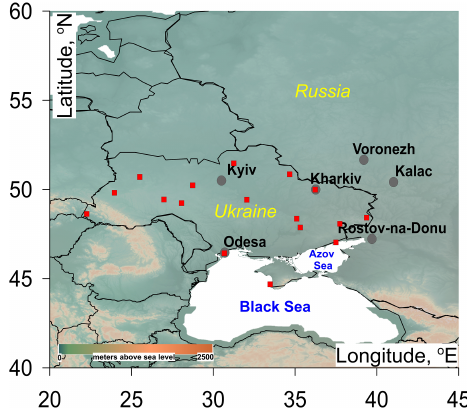
Figure 1. The area of interest and geographical locations of the radiosounding stations (black circles – Kyiv, Odesa, Kharkiv, Voronezh, Rostov-on-Don, Kalac) and air pollution monitoring sta- tions (red squares) used in this